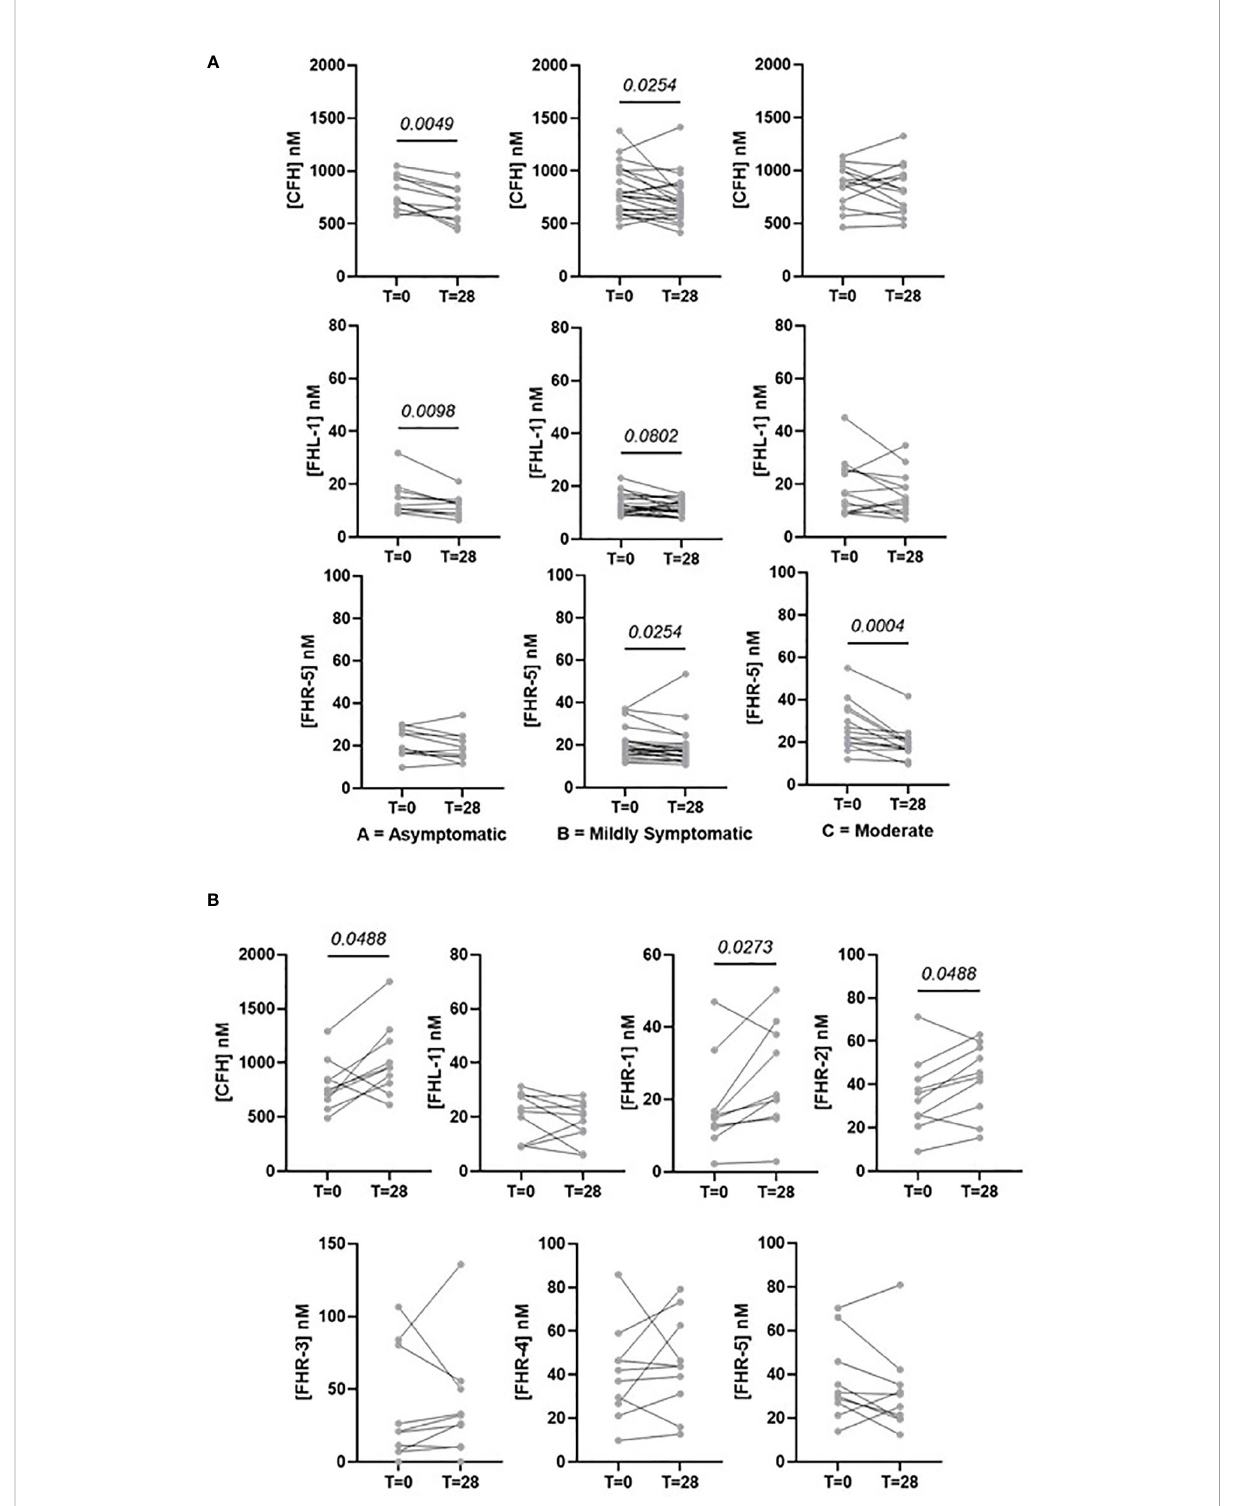
FIGURE 4 Selected pairwise comparisons of circulating concentrations of FHL-1 and FHR1 to FHR5 in COVID-19 patients after 28 days. (A) CFH, FHL-1 and FHR5 in asymptomatic to moderate symptomatic individuals. (B) CFH, FHL-1 and FHR1-5 in patients with critical (Group E)